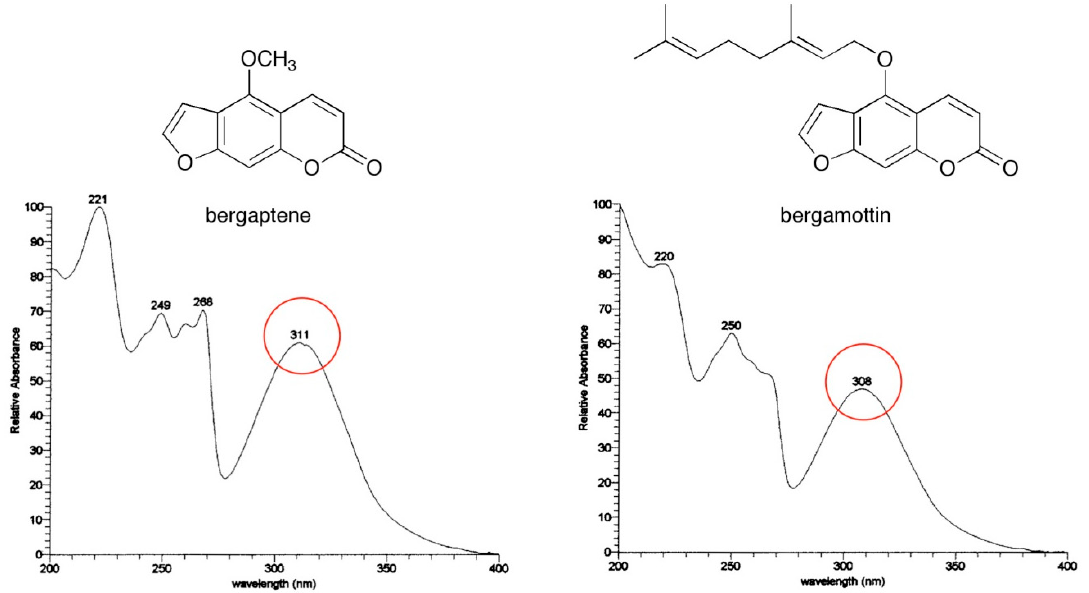
Figure 2. UV / Vis spectra of bergaptene ( left ) and bergamottin ( right ), two psoralens from Citrus Figure 2. UV/Vis spectra of bergaptene (left) and bergamottin (right), two psoralens from Citrus bergamia bergamia Risso.